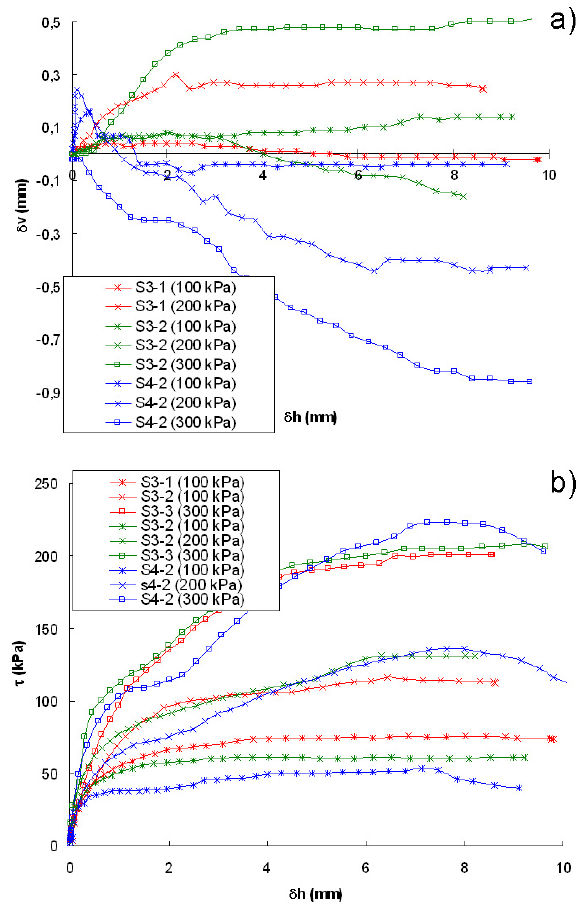
Fig. 8. Results of direct shear tests performed on samples of gneis- sic cover, expressed in terms of vertical displacement vs. shear dis- placement (a) and shear stress vs. shear displacement (b) .